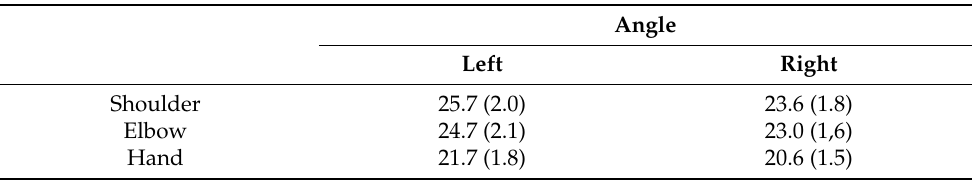
Table 2. Average (S.E.) of minimum comfortable distance in centimeters considering the approach angle for each body part.